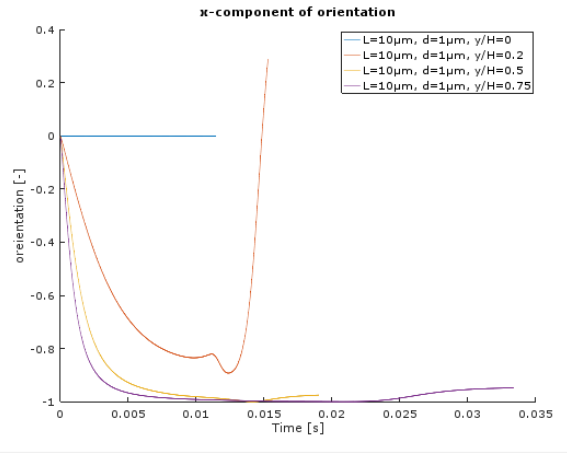
Fig. 5. The x-component of fibre orientation in